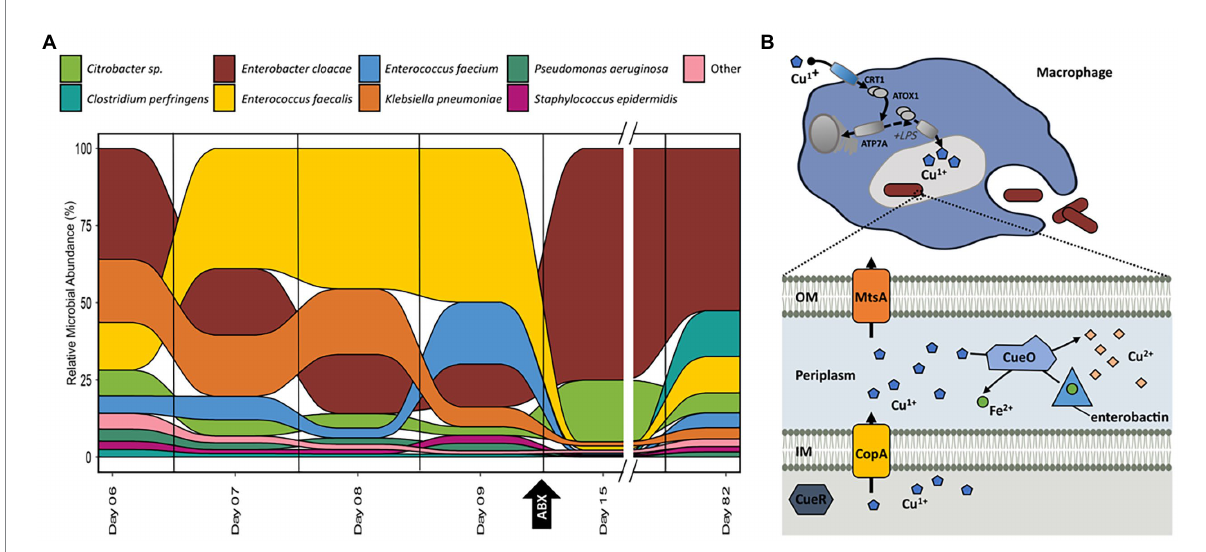
FIGURE 4 (A) Relative abundance of organisms at each time-point for samples collected for infant 61 based on the summed protein expression of each organism. Taxonomic assignment of proteins determined previously in Brown et al. (2018). (B) Graphical representation of copper/iron-related activities between the host immune system and E. cloacae in infant 61 based on the pathways and proteins detected in samples from this infant. Additional proteins related to these processes are listed in supplemental